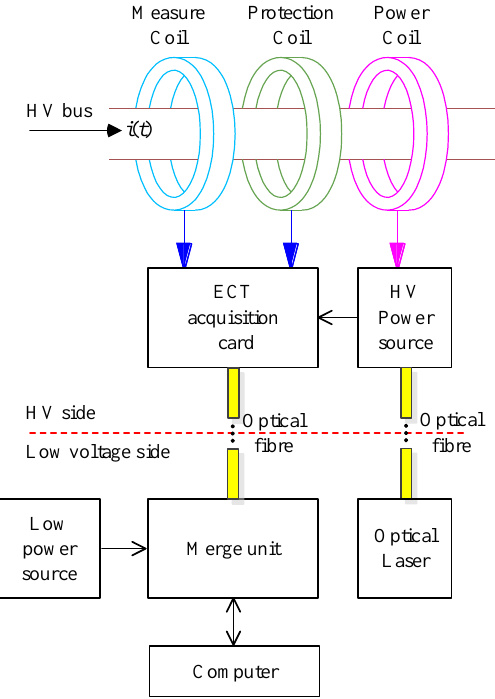
Figure 1. The signal acquisition system of the electronic current transformer (ECT) in a substation .